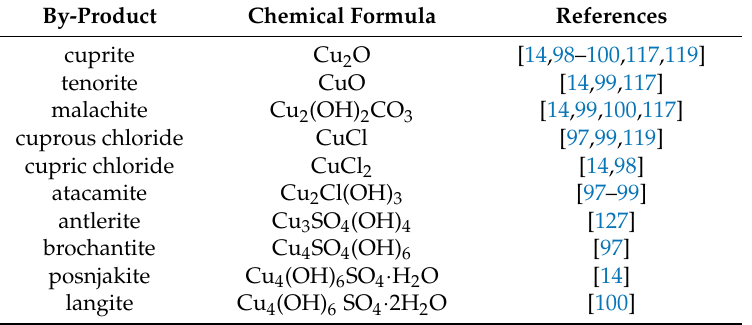
Table 2. Copper solid by-products of interest detected by X-ray Diffraction (XRD) in corrosion episodes.